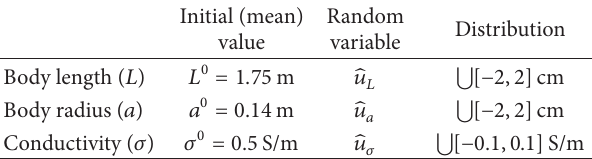
Table 2: Random input variables.